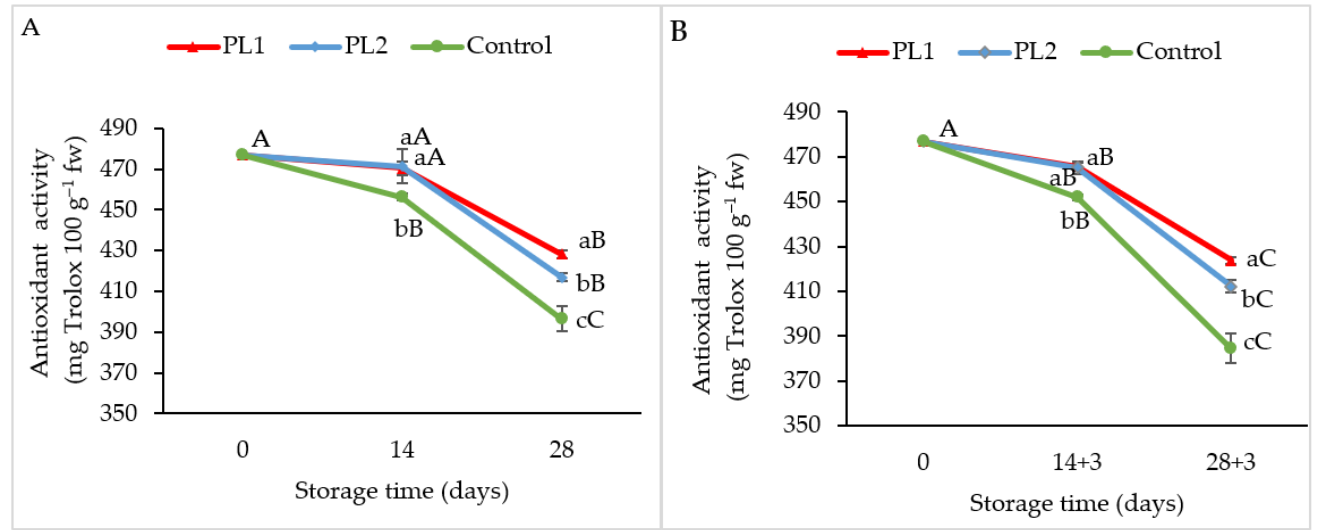
Figure 4. Antioxidant activity changes during cold storage ( A ) and shelf life ( B ). Data are the mean ± SE of three replicates of twenty-two fruit. Different uppercase letters indicate significant differences for each atmosphere composition during storage, and different lowercase letters indicate significant differences among atmosphere compositions for each sampling date at p < 0.05.